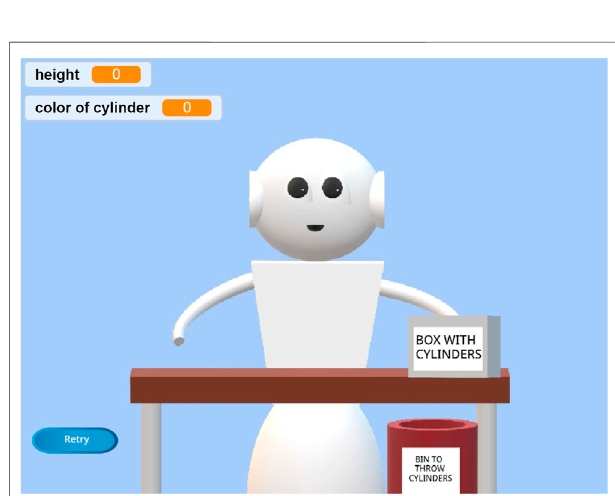
FIGURE 2 | The navigation task in which the robot (A) needs to move from the living room, through the kitchen, to the hallway and to the charging station (C) , charge its battery, and move back. If the cat (B) (controlled by a variable that is either or 1) blocks the door, the robot fi rst needs to make the cat move.